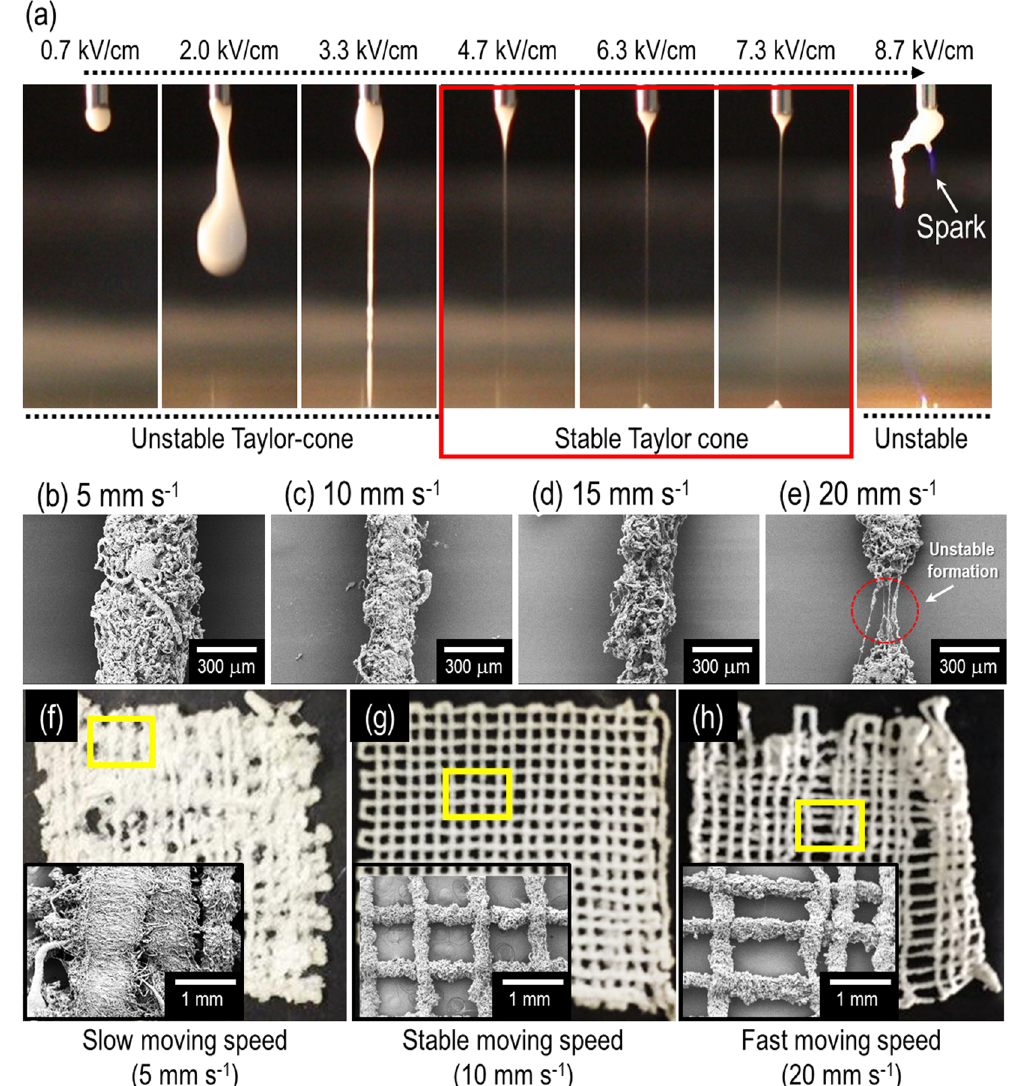
Figure 2. ( a ) Optical images of an initial jet exited from the nozzle tip for various electric fields (0.7~8.7 kV/ cm) with respect to a height of 1.5 cm. The red region indicates the stable Taylor-cone and initial jet behavior. SEM images showing single struts fabricated at ( b ) 5 mm s − 1 , ( c ) 10 mm s − 1 , ( d ) 15 mm s − 1 , and ( e ) 20 mm s − 1 of moving speed. Optical and SEM images of the mesh structure fabricated with the moving speeds, ( f ) 5 mm s − 1 , ( g ) 10 mm s − 1 , and ( h ) 20 mm s − 1